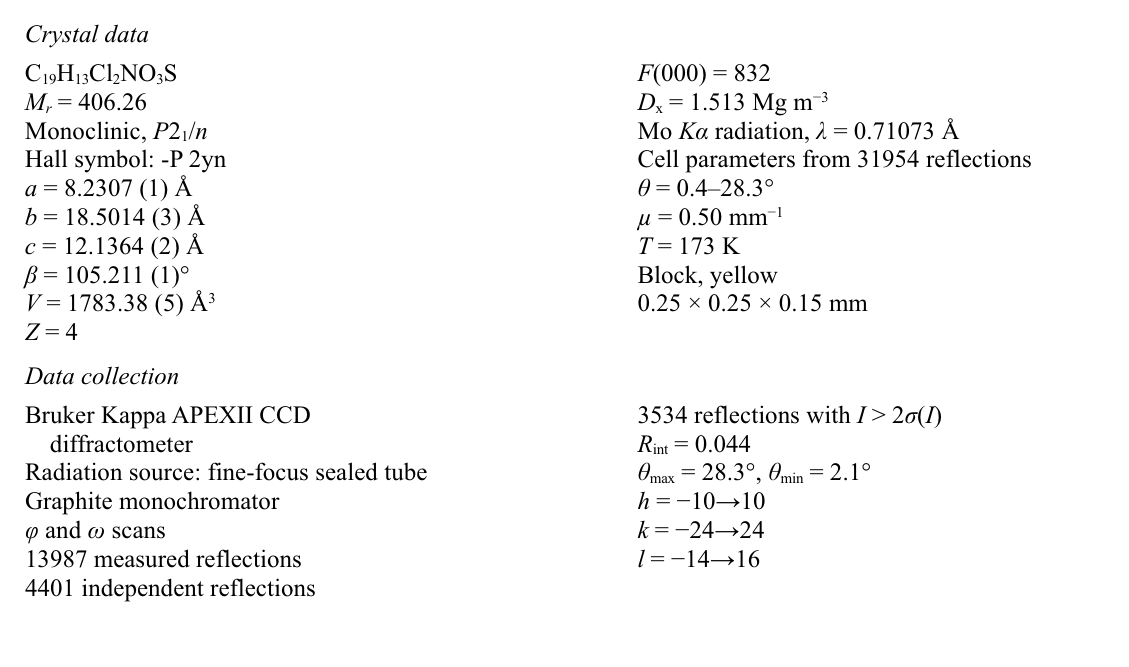
Packing viewed along the a -axis showing the stack-like architecture N -(2-Benzoyl-4-chlorophenyl)-4-chlorobenzenesulfonamide Crystal